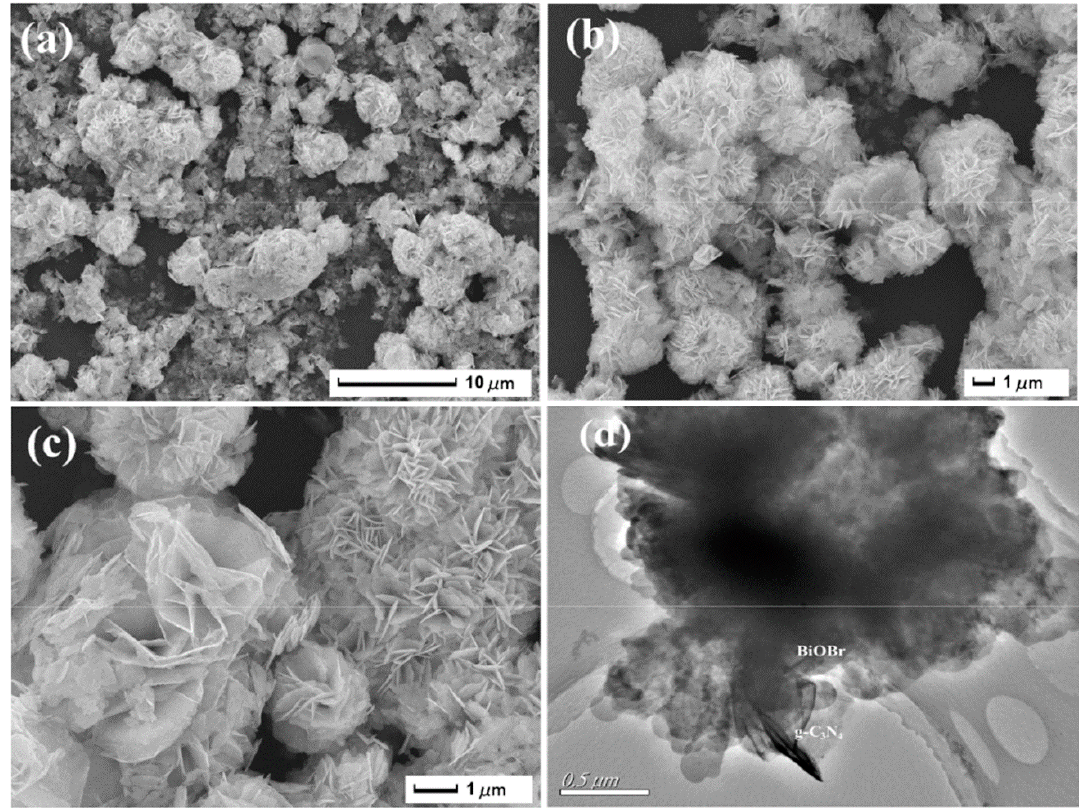
Figure 4. ( a ) Low magnification and ( b , c ) magnified FESEM and ( d ) TEM micrographs of g-C 3 N 4 /BiOBr microspherical composites synthesized by ionic liquid assisted solvothermal method. Reprinted from Ref. [88] with permission from The Royal Society of Chemistry.